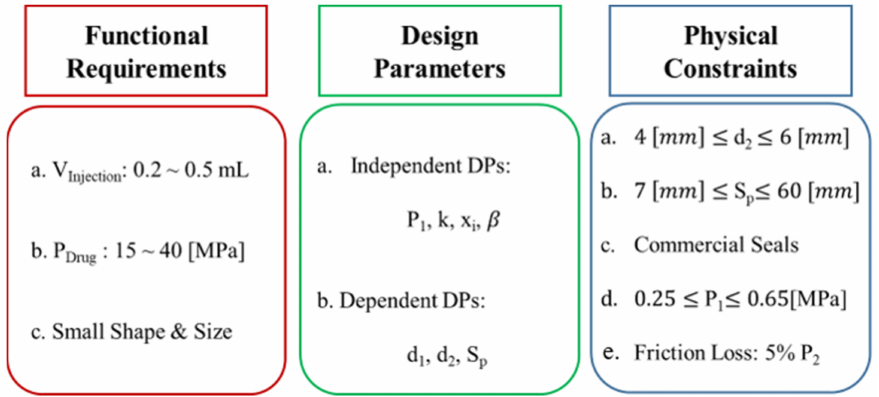
Figure 6. Design considerations for the needle-free jet injector using the axiomatic design approach.